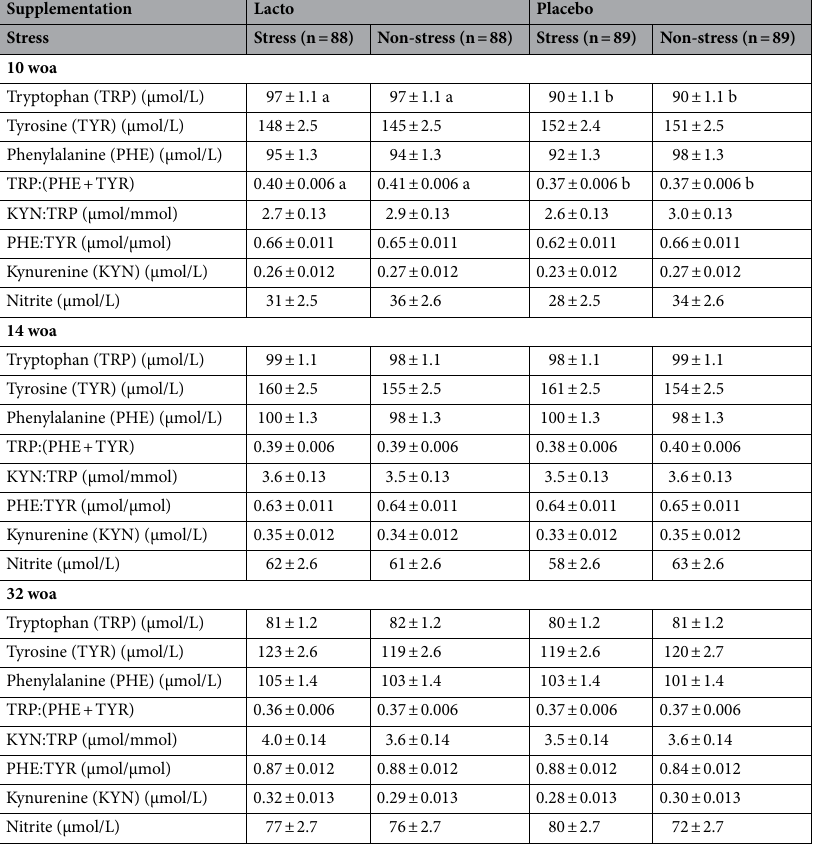
Table 2. Least Squares Means (± Standard Error) of amino acid concentrations, kynurenine and nitrite (n of birds: S-Placebo = 89, NS-Placebo = 89, S-Lacto = 88, NS-Lacto = 88) at 10, 14 and 32 weeks of age (woa). The birds were submitted to 9 weeks (0–9 woa) of supplementation (Lacto: L. rhamnosus, Placebo: water) and 3 weeks (11–13 woa) of stress treatment (stressed, non-stressed). Different letters indicate statistically significant differences within the same row (P <